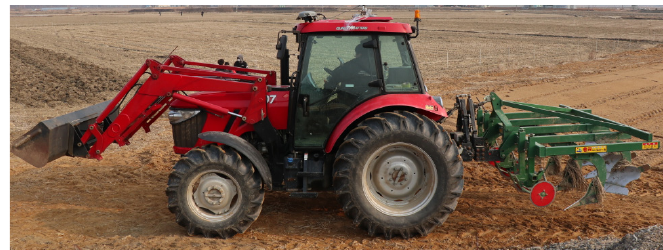
Figure 1. The 78 kW class agricultural tractor used for the field experiment.